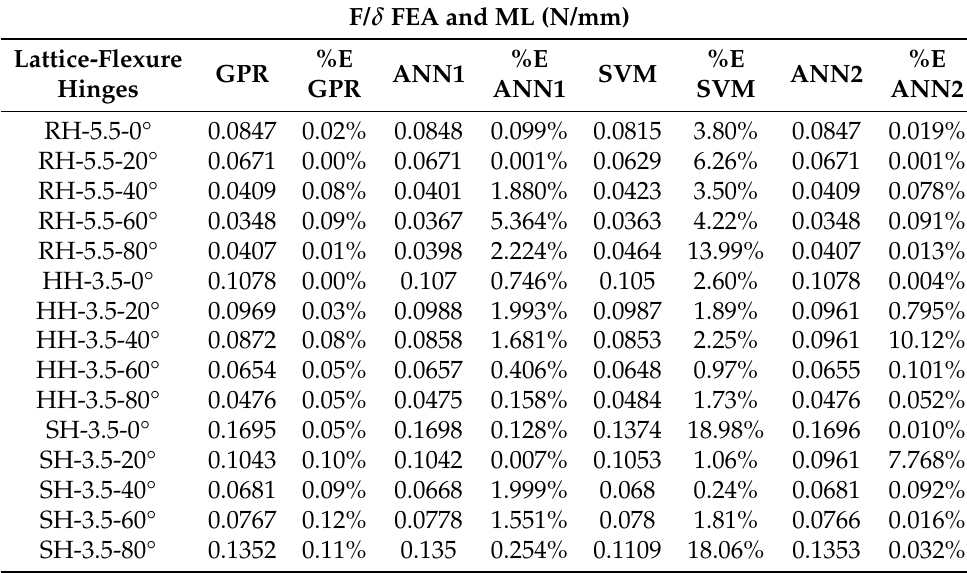
Table 3. Stiffness prediction errors (%E) between FEA and ML